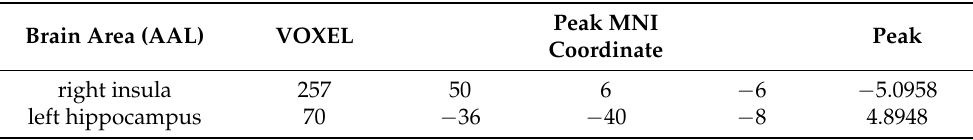
Table 2. Brain regions showing abnormal CBF with the right insula and the left hippocampus in the CKD4 group ( p < 0.05).